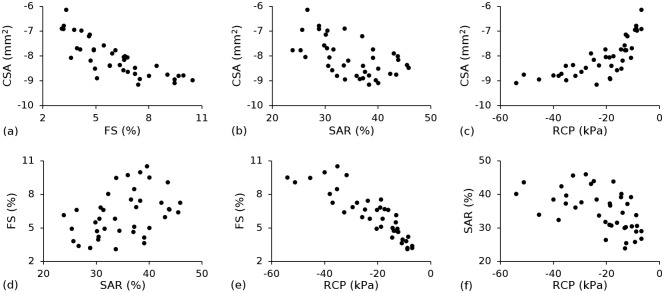
Trade-off curves for all permutations of the four performance metrics: (a) CSA vs. FS; (b) CSA vs. SAR, (c) CSA vs. RCP and (d) FS vs. SAR, (e) FS vs. RCP and (f) SAR vs. RCP.